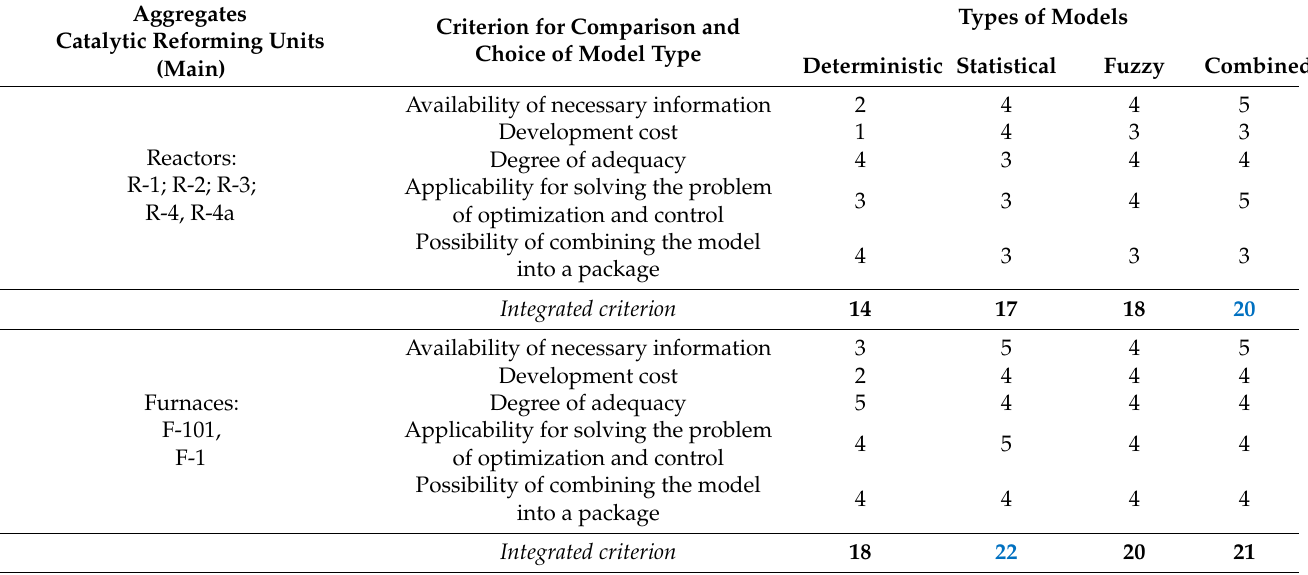
Table 1. Analysis and assessment of the types of models of the main units of the reforming unit